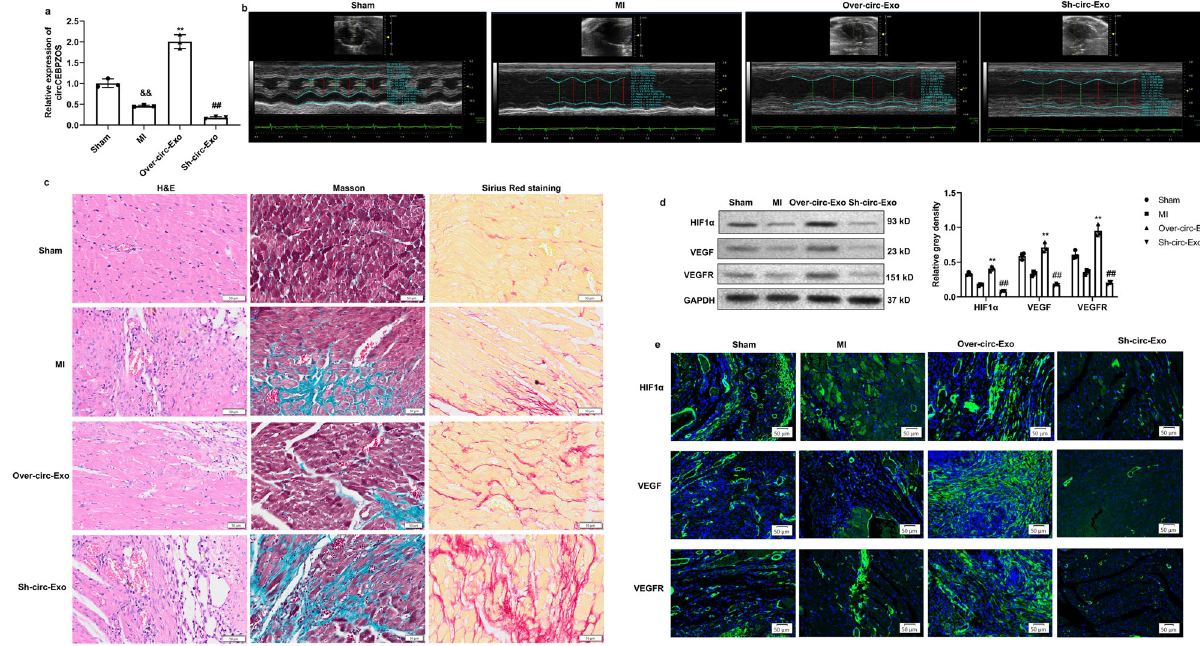
Fig. 8 circCEBPZOS alleviated postinfarct cardiac remodeling. a qRT – PCR was used to verify the expression of circCEBPZOS in heart tissue treated with exosomal circCEBPZOS. GAPDH served as a control. b Echocardiographic measurements to detect the in the model group compared with sham group; c Pathological changes detected by HE, Masson and Sirius Red staining in heart tissue treated with circCEBPZOS, Bar = 50 μ m; d Western blotting analysis to detect the expression of HIF-1 α , VEGF and VEGFR in the Over-circa-Exo group or Sh-circa-Exo group. GAPDH served act as control;